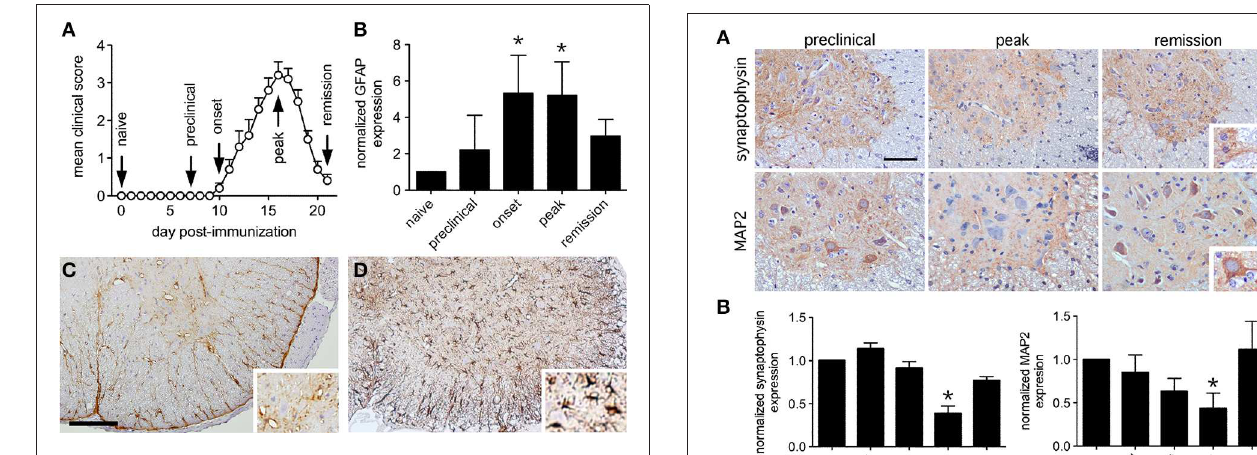
FIGURE 1 | Astrocytes are activated in both gray and white matter of the lumbar ventral spinal cord during relapsing EAE. (A) The clinical course of relapsing EAE induced by active PLP peptide immunization of SJL mice shows near complete resolution of paralysis over only a few days ( n = 20 ). (B) Normalized spinal cord GFAP levels at defined stages of relapsing EAE shows evidence of astrocyte activation at disease onset ( n = 5 samples per disease stage). (C) Representative immunohistochemical staining for GFAP expression in naïve SJL spinal cord shows expression in quiescent-appearing cells that predominate in white matter. Insert shows modest signal in ventral gray matter. (D) Representative GFAP staining of SJL spinal cord at peak EAE shows increased signal in both white and gray matter. Insert shows numerous activated GFAP + astrocytes in ventral gray matter. * p < 0.05 compared to preclinical levels, Bar = 100 µ m.